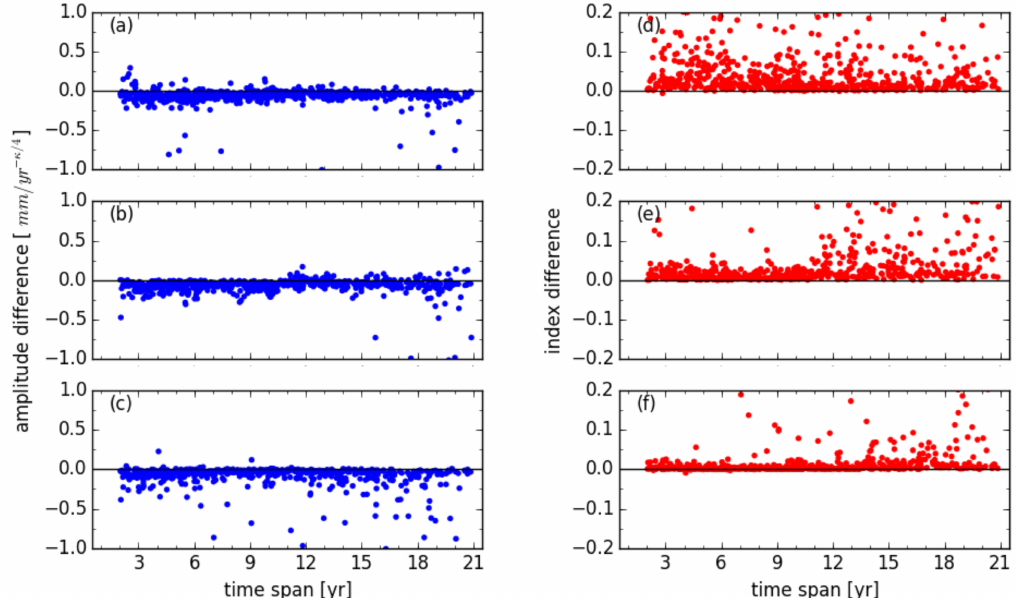
Figure 4. Noise difference between the solution sim_unit_none and sim_cova_none for amplitudes ( left panel ) and spectral indexes ( right panel ) of power-law noise, with ( a , d ) for the east, ( b , e ) for the north, and ( c , f ) for the vertical component.